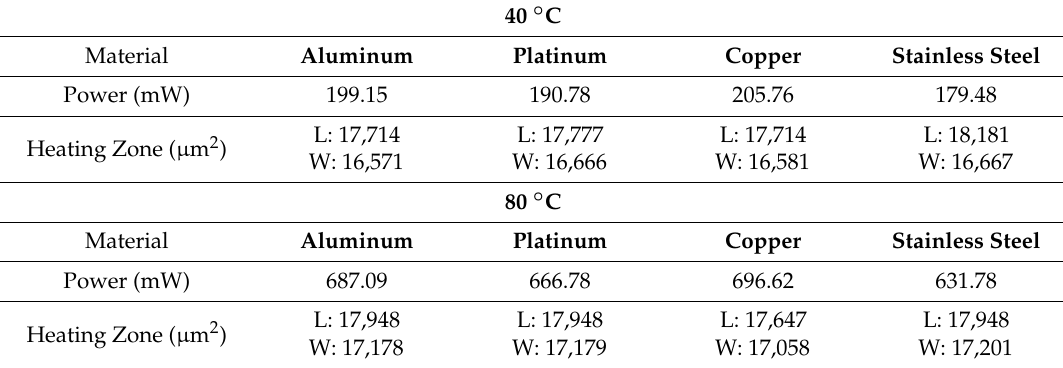
Figure 6. Typical simulation of thermal distribution profile on the surface of the thermostat at 40 ◦ C. Table 2. Power consumption and thermal distribution of each thermostat at 40 ◦ C and 80 ◦ C.